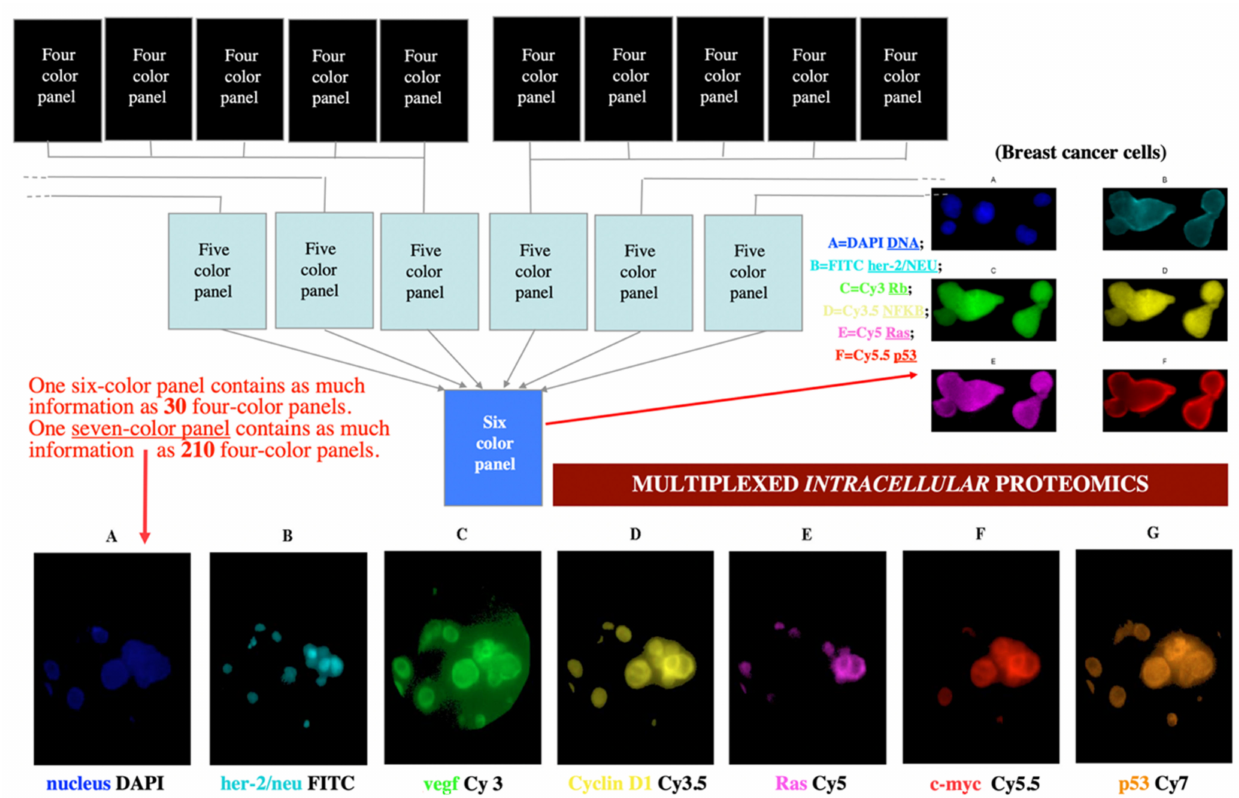
Figure 11. Four to seven-parameter imaging of breast cancer cells. In the most informative case (bottom) images (left to right) are of cells labeled simultaneously with seven different probes: ( A ) the nucleus labeled with DAPI, ( B ) her-2/neu labeled with FITC, ( C ) vegf labeled with Cy3, ( D ) Cyclin D1 labeled with Cy3.5, ( E ) ras labeled with Cy5, ( F ) c-myc labeled with Cy5.5, and ( G ) p53 labeled with Cy7. These were acquired using four separate filter sets (DAPI/FITC/Cy3/Cy5-Cy7) and an AOTF module was used to distinguish between the dyes contained within the filter sets. Up to 10 labels/parameters could be imaged in similar experiments. Spectra from the individually labeled preparations were used as reference spectra to extract the relative amount of each component in the multiply labeled specimen using standard analysis such as least